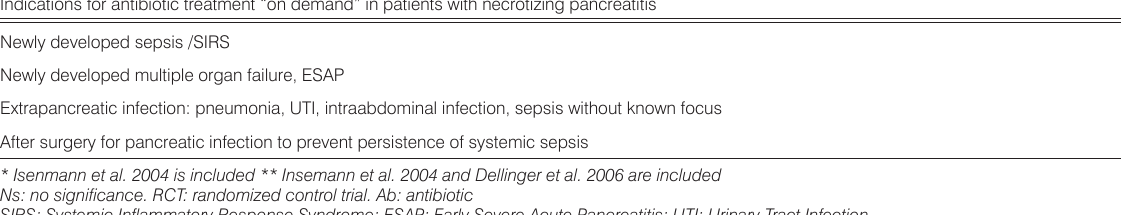
Table 7 . Treatment “on demand” Indications for antibiotic treatment “on demand” in patients with necrotizing pancreatitis Newly developed sepsis